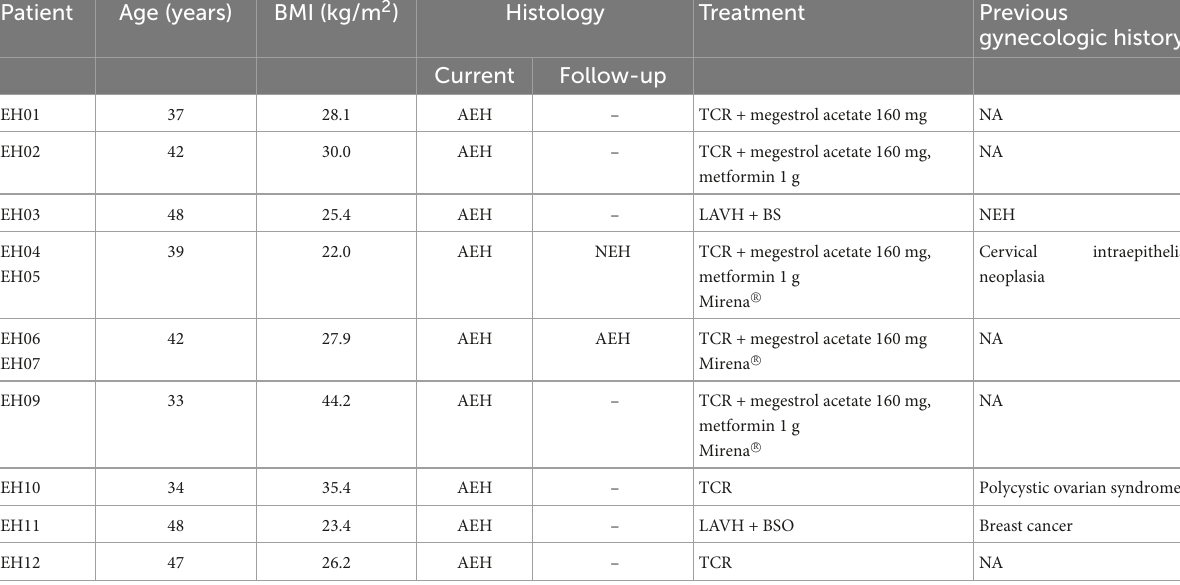
TABLE 1 Clinicopathologic characteristics of women with atypical endometrial hyperplasia.